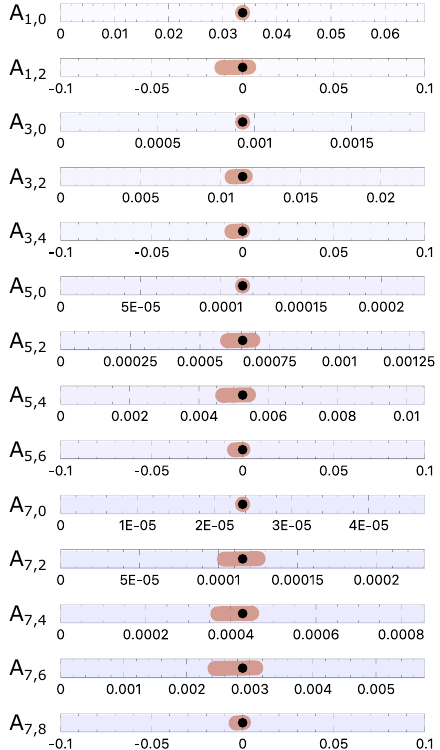
Fig. 5 Result of constraining the ANN model using 400 points eval- uated with the GK model [25–27] for sea quarks: x (cid:5)= ξ case, positiv- itynotenforced,allthreecontributions( F C (β,α), F S (β,α), F D (β,α) ) used in the presentation of results. The plot shows the first Mellin coef- ficient for odd moments (even moments strictly vanish) evaluated for the GK (black dots) and ANN (solid bands)